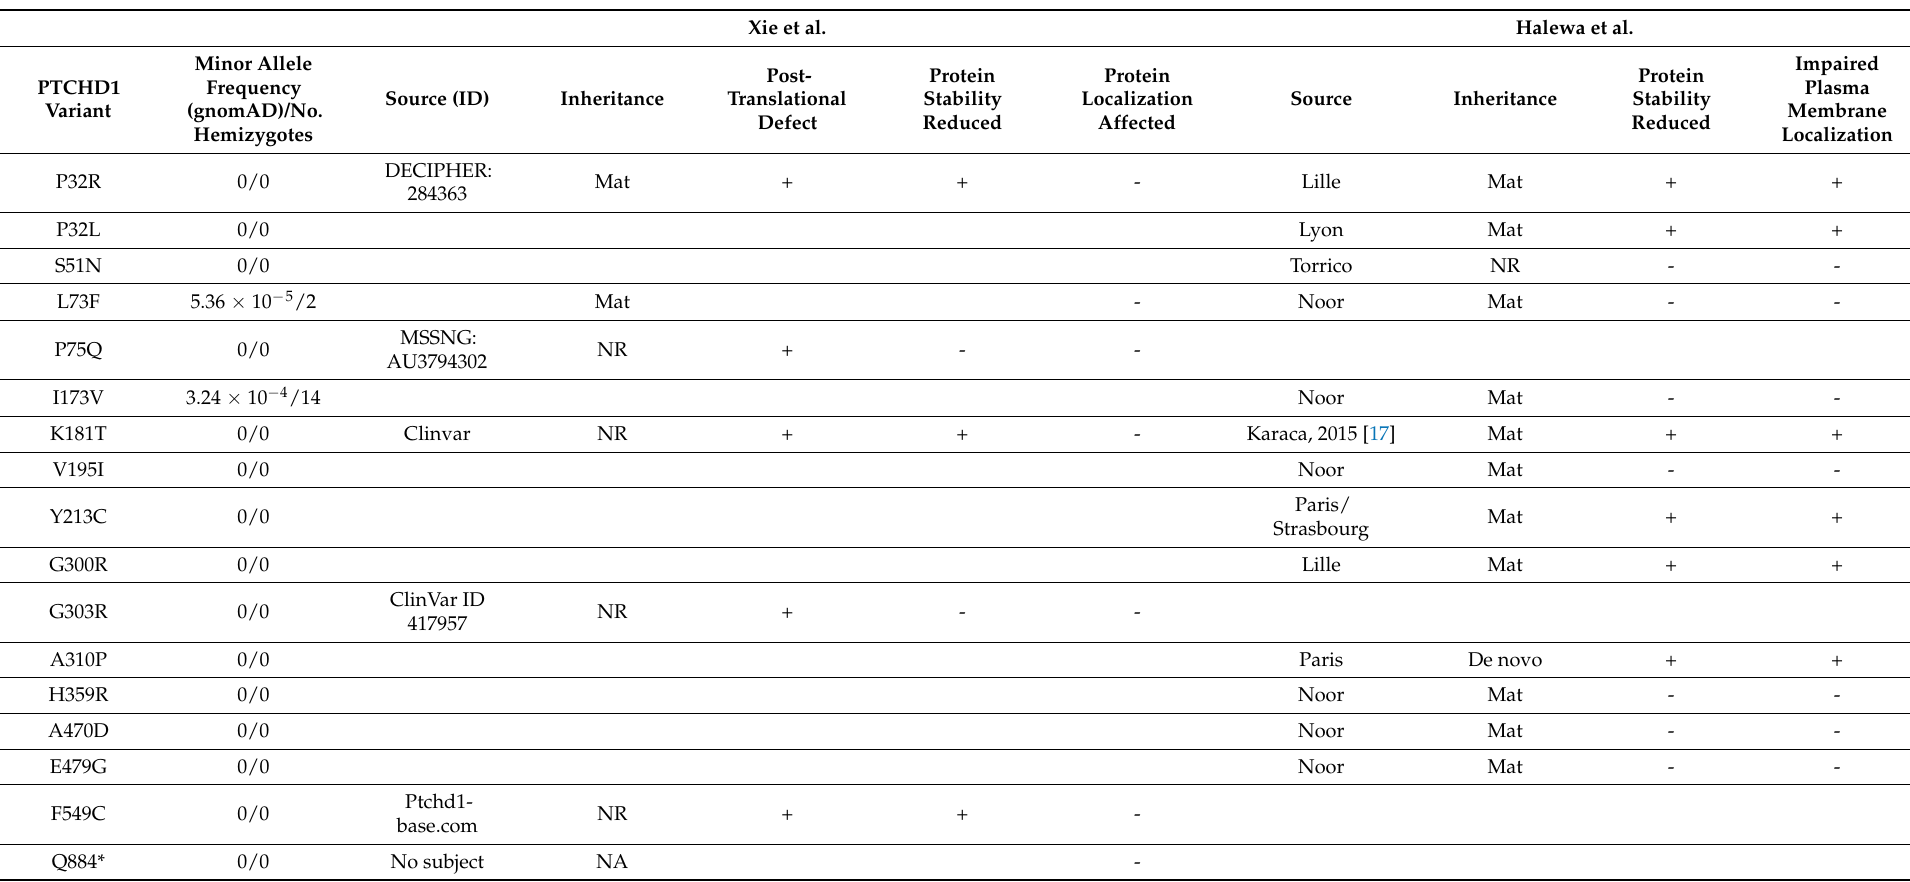
Table 1. Summary of functional analysis of missense PTCHD1 variants from Xie et al. [37] and Halewa et al. [16]. Xie et al. Halewa et